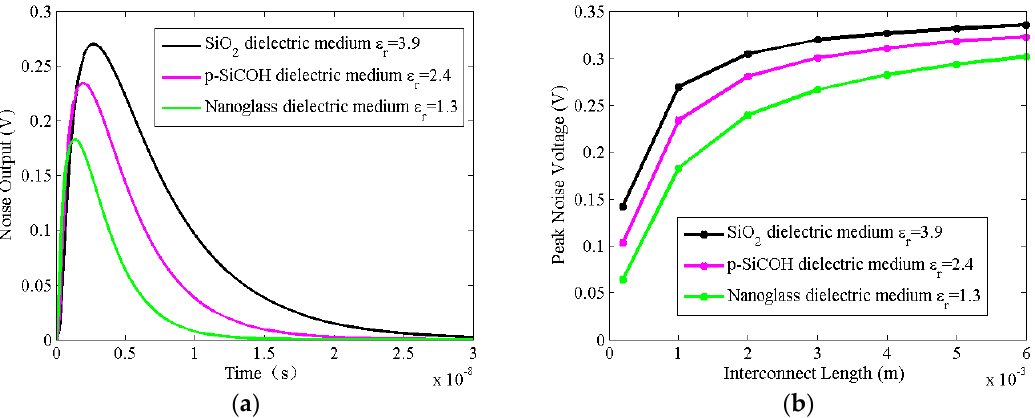
Figure 5. The impacts of different dielectric materials on ( a ) noise output voltage with interconnect length L gnr = 1000 µm and ( b ) peak noise voltage for different interconnect length.